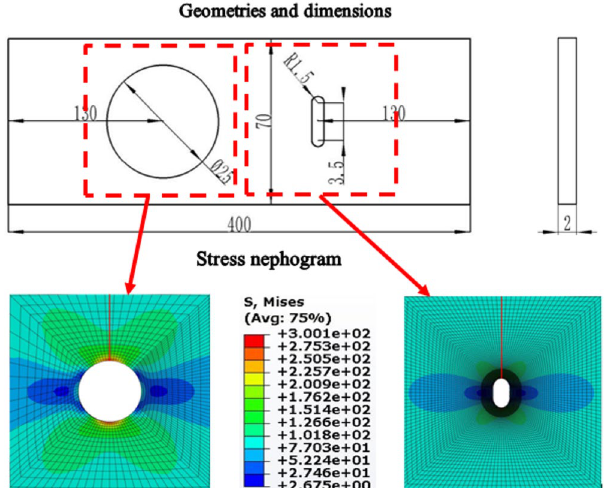
Figure 13. Geometries and dimensions of DH-A specimen and stress nephogram of the two notch roots under stress level 80 MP. (Unit: mm).